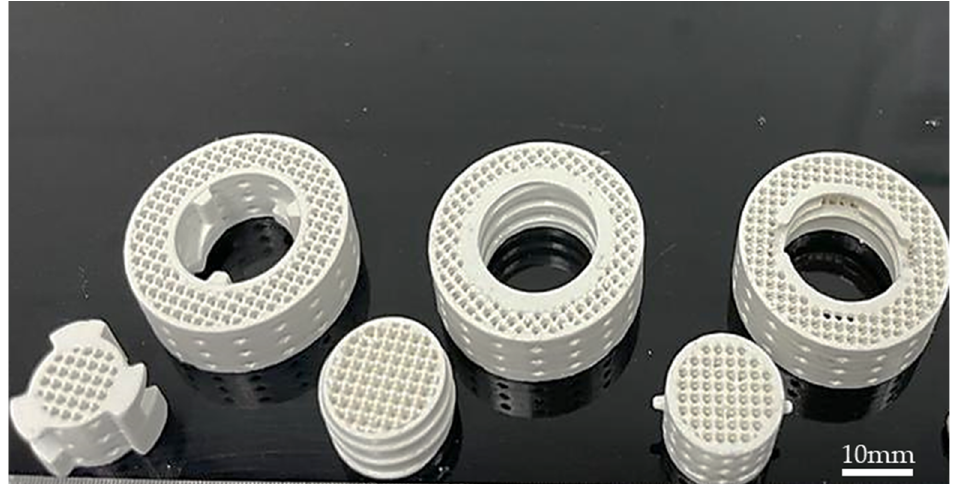
Figure 6. Green parts (from left to right: U-lock, Thread, Twist-lock).